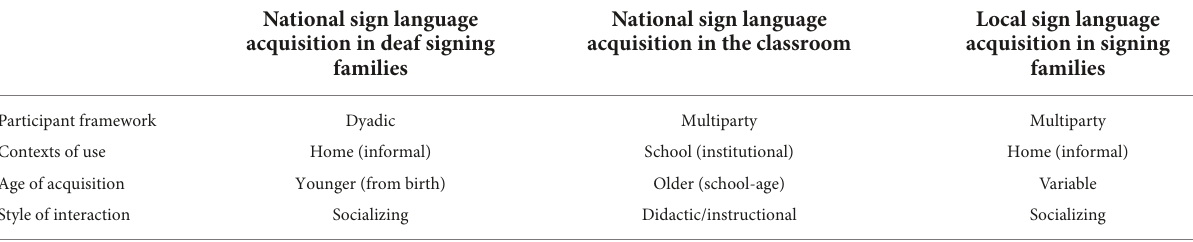
TABLE 8 Differences in the social ecologies of home and school as primary sites of sign language